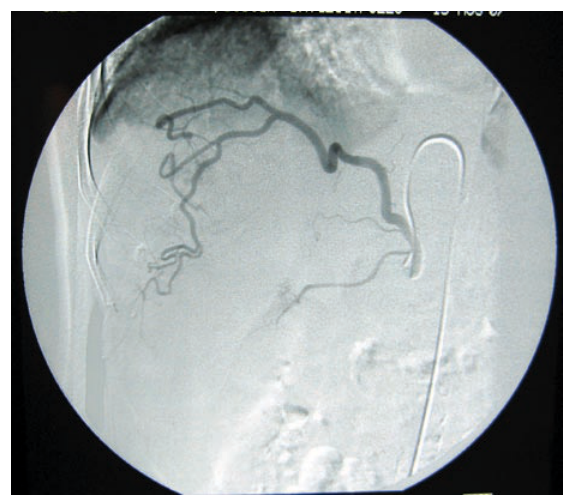
Figure 3. Radiograph of the chest. Figure 4. Hepatic angiogram.